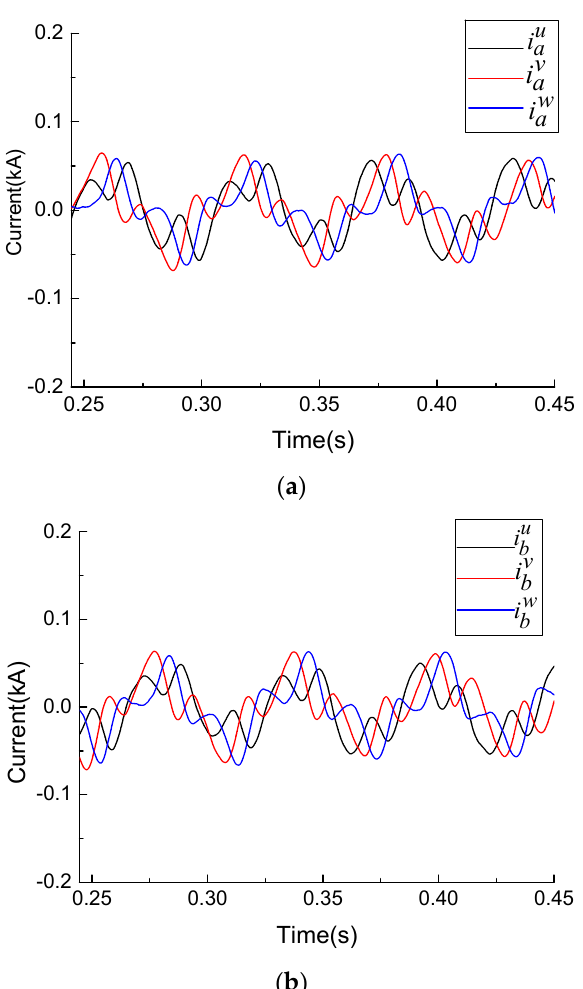
Figure 5. Branch current waveforms of subconverter a and b: ( a ) subconverter a; ( b ) subconverter b.